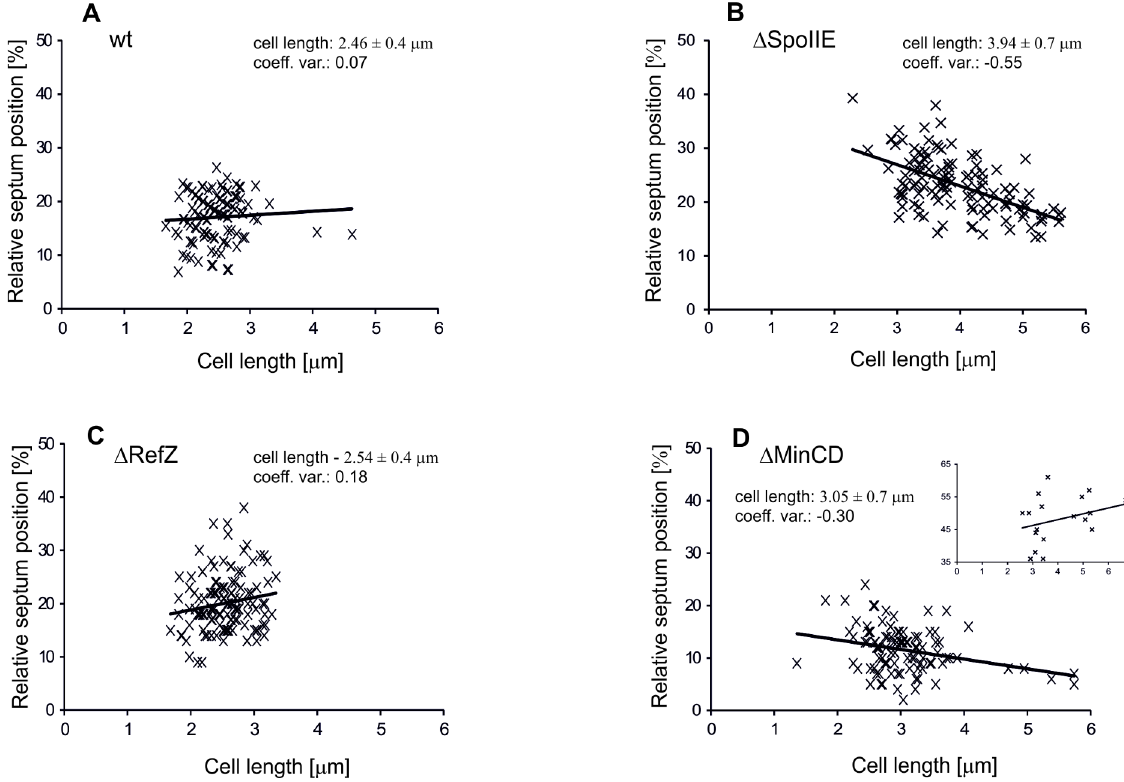
Fig 2. Scatter plots. Plots showing the asymmetric septum location in fractions of cell length in the wild type, Δ SpoIIE, Δ RefZ and Δ MinCD